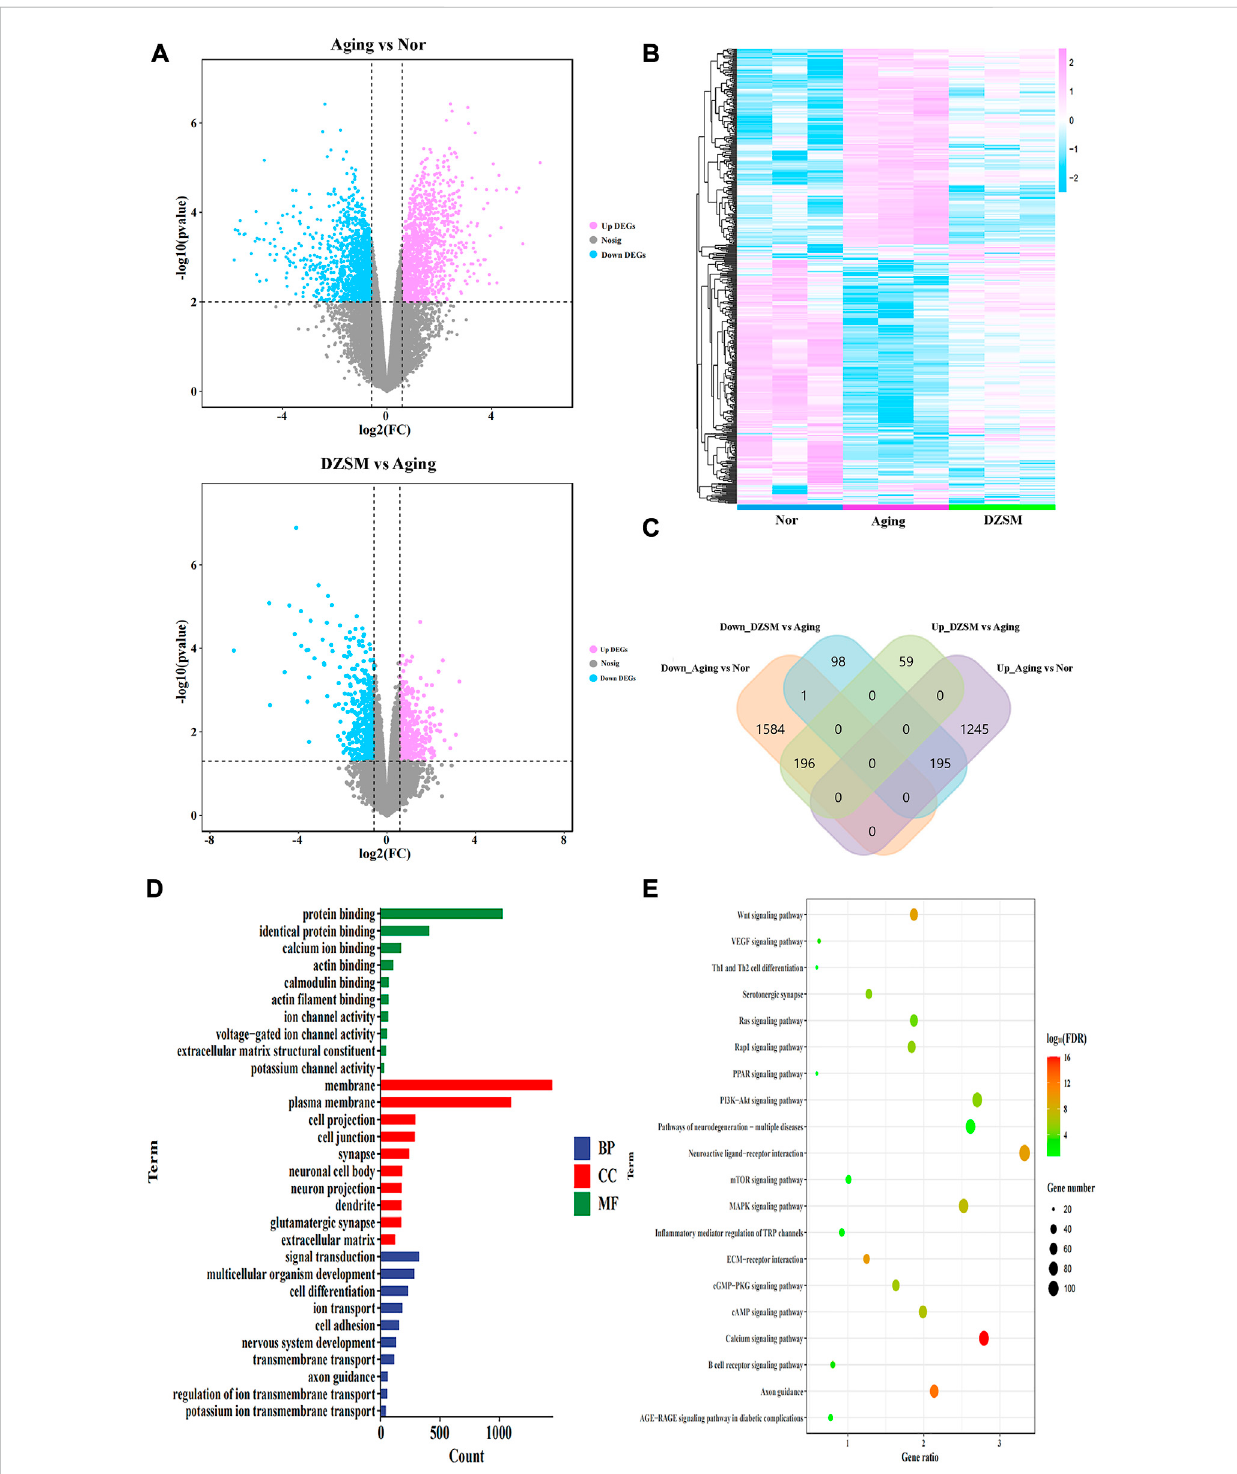
FIGURE 3 Transcriptomics analysis. (A) Volcano map of the DEGs in the Aging vs. Normal (Nor) groups and the DZSM vs. Aging groups; (B) Heatmap of the DEGs in the Nor, Aging, and DZSM groups; (C) Venn diagram of the DEGs in the Nor, Aging, and DZSM groups; (D) GO enrichment analysis of DEGs (red terms represent MF, green terms represent CC, and blue terms represent BP). (E) KEGG pathway analysis of